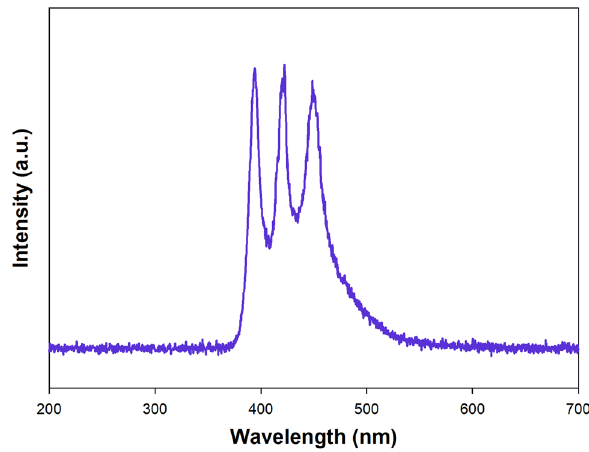
Figure 1. The spectrum of matched LED light source used for photooxidation